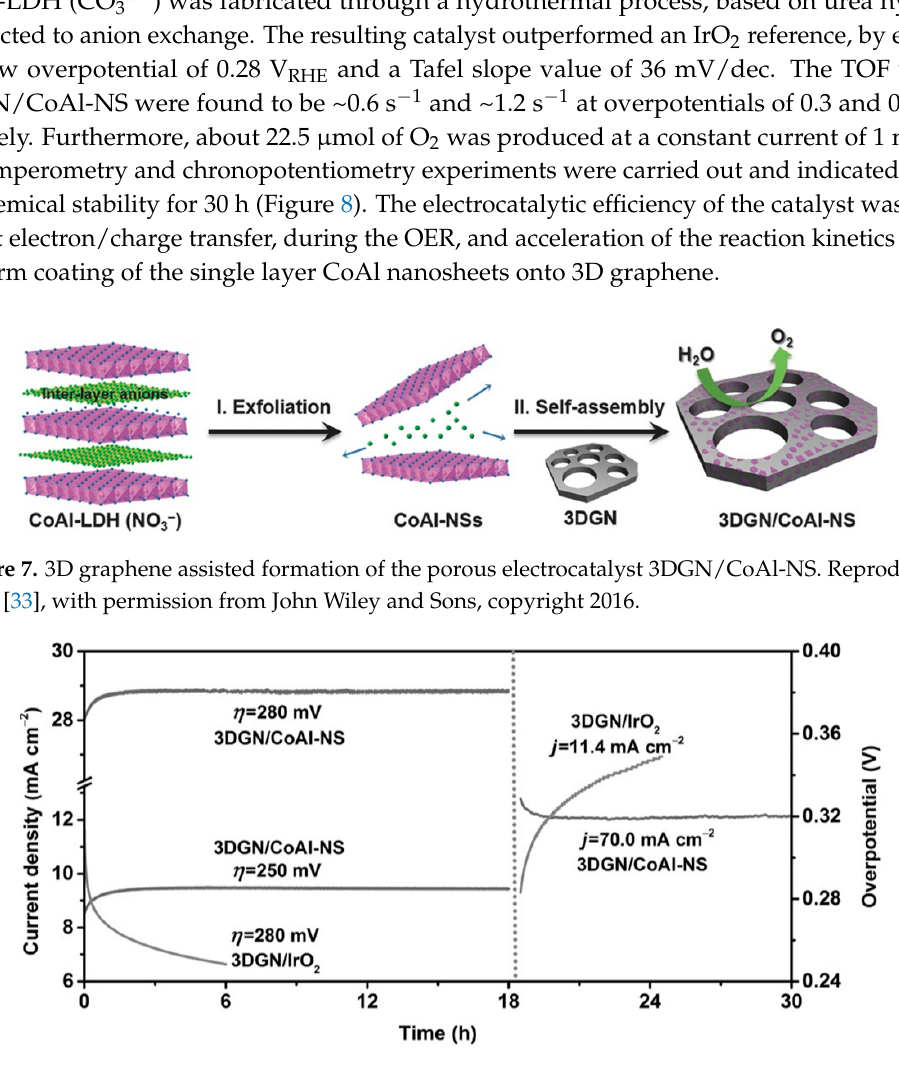
Figure 8. Chronoamperometric measurements of 3DGN/CoAl-NS and 3DGN/IrO 2 in 1M KOH. Left plot: 3DGN/CoAl-NS at η = 0.25 and 0.28 V RHE , and 3DGN/IrO 2 at η = 0.28 V RHE . Right plot: 3DGN/CoAl-NS at j = 70 mA cm − 2 , and 3DGN/IrO 2 at j = 11.4 mA cm − 2 . Reproduced from [33], with permission from John Wiley and Sons, copyright 2016.